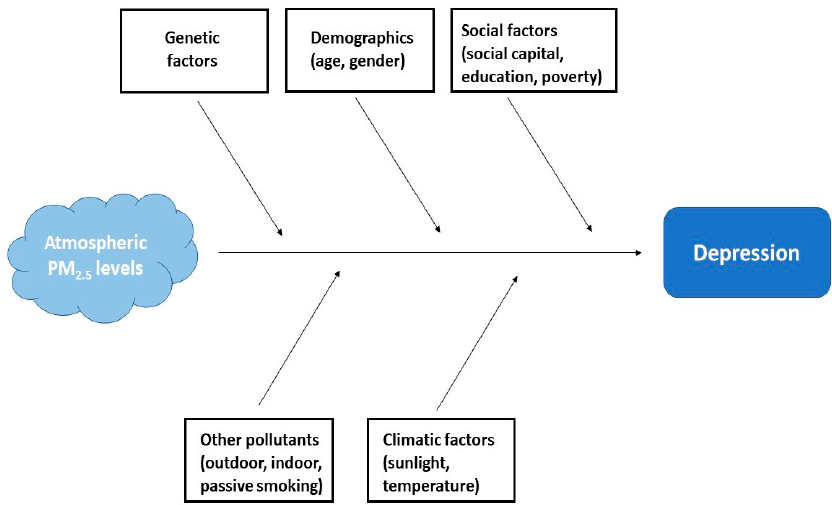
Figure 2. The complex nature of the relationship between PM 2.5 and depression.